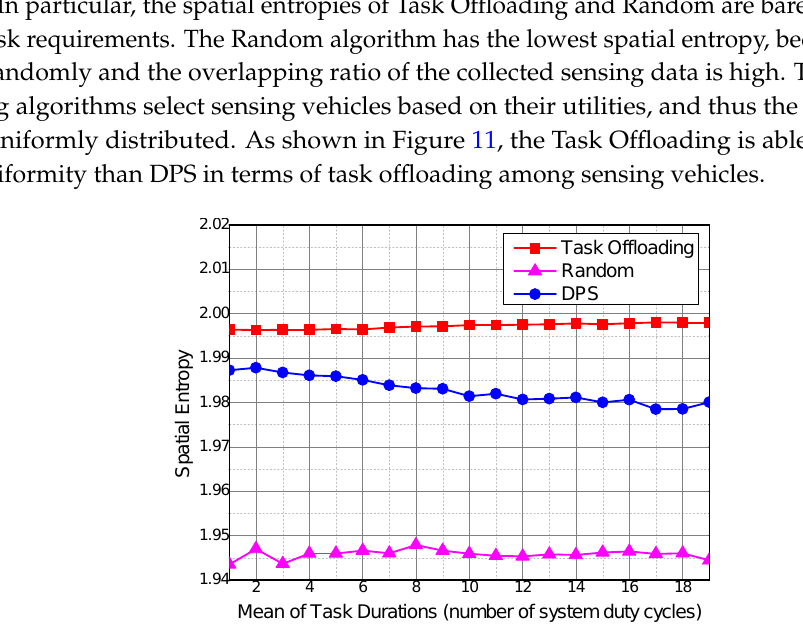
Figure 11. Spatial entropy under different mean values of task